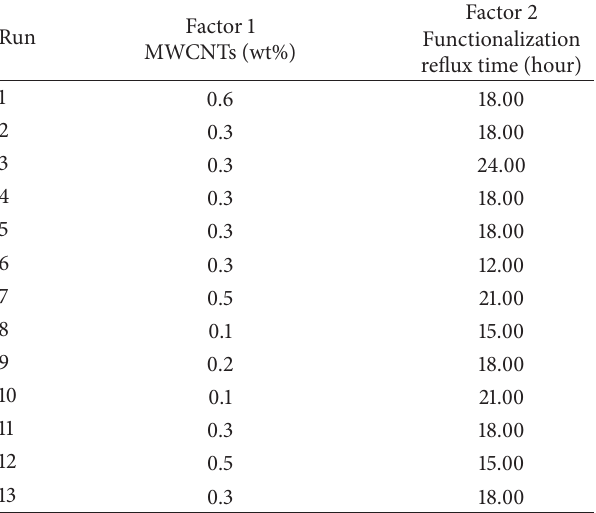
Table 2: Experimental design